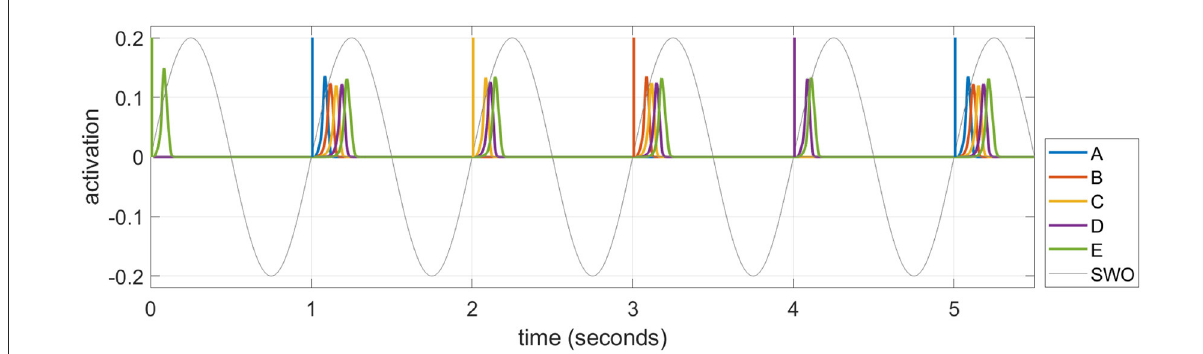
FIGURE5 A series of time-compressed replays during UP states in SWS. The last six replays on Night 1 after training the sequence ABCDE for 10 trials are plotted. The initial item in each replay is selected from a weighted distribution based upon the recent activation of each item (i.e., the salience), and its activity spreads to the subsequent items of the pertinent sequence stored in memory. In this example, six replays are generated by cueing “E,” “A,” “C,” “B,” “D,” and “A” in turn. The duration of the cue to initiate the replay in each UP state is 12.5 ms, and the amplitude is 0.2. Note a 1 Hz SWO is superimposed for